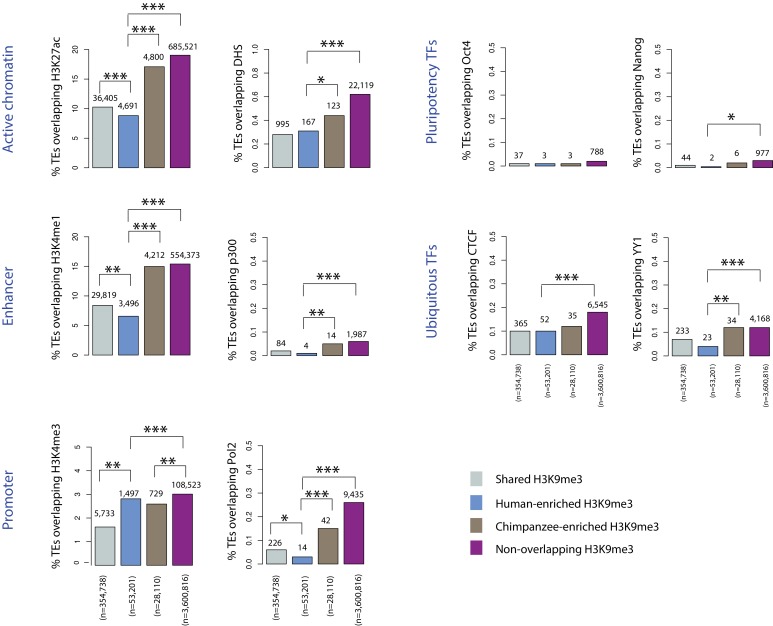
TEs preferentially silenced by H3K9me3 in human are depleted for regulatory regions in human relative to TEs preferentially silenced in chimpanzee.The proportion of orthologous TEs within each of the four H3K9me3 silencing categories (Shared, Human-enriched, Chimpanzee-enriched and Non-overlapping) that overlap with human ChIP-seq and DNase I hypersensitivity data. Only a small subset of orthologous TEs overlap human regulatory regions, but plots are scaled so that differences between categories can be visualized. The number of instances in each category is indicated above each bar. Asterisk denotes a significant difference between categories (Pearson’s Chi-squared test; *p<0.01, **p<0.001, ***p<0.0001).